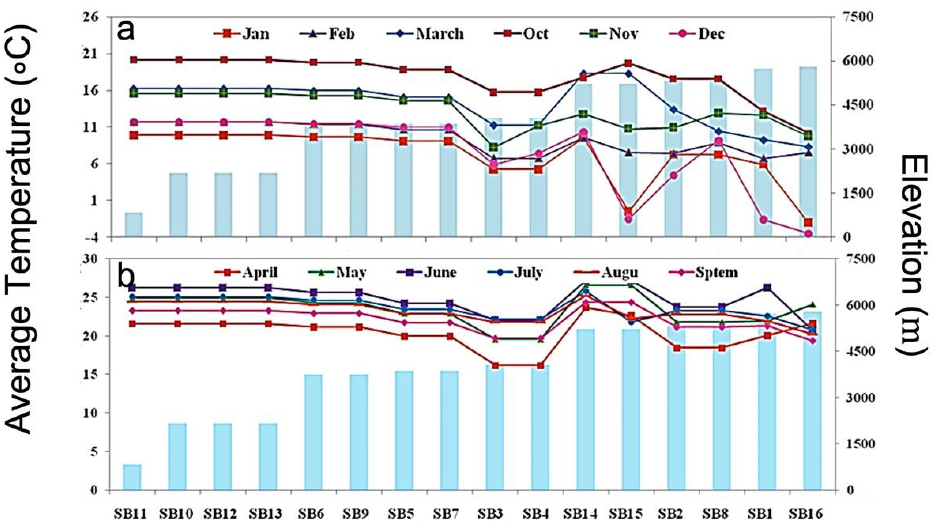
Figure 5. Changes of average temperatures along multiple sub-watersheds. The bar indicates the elevation of the centroid for ( a ) winter months and ( b ) summer months. elevation of the centroid for ( a ) winter months and ( b ) summer